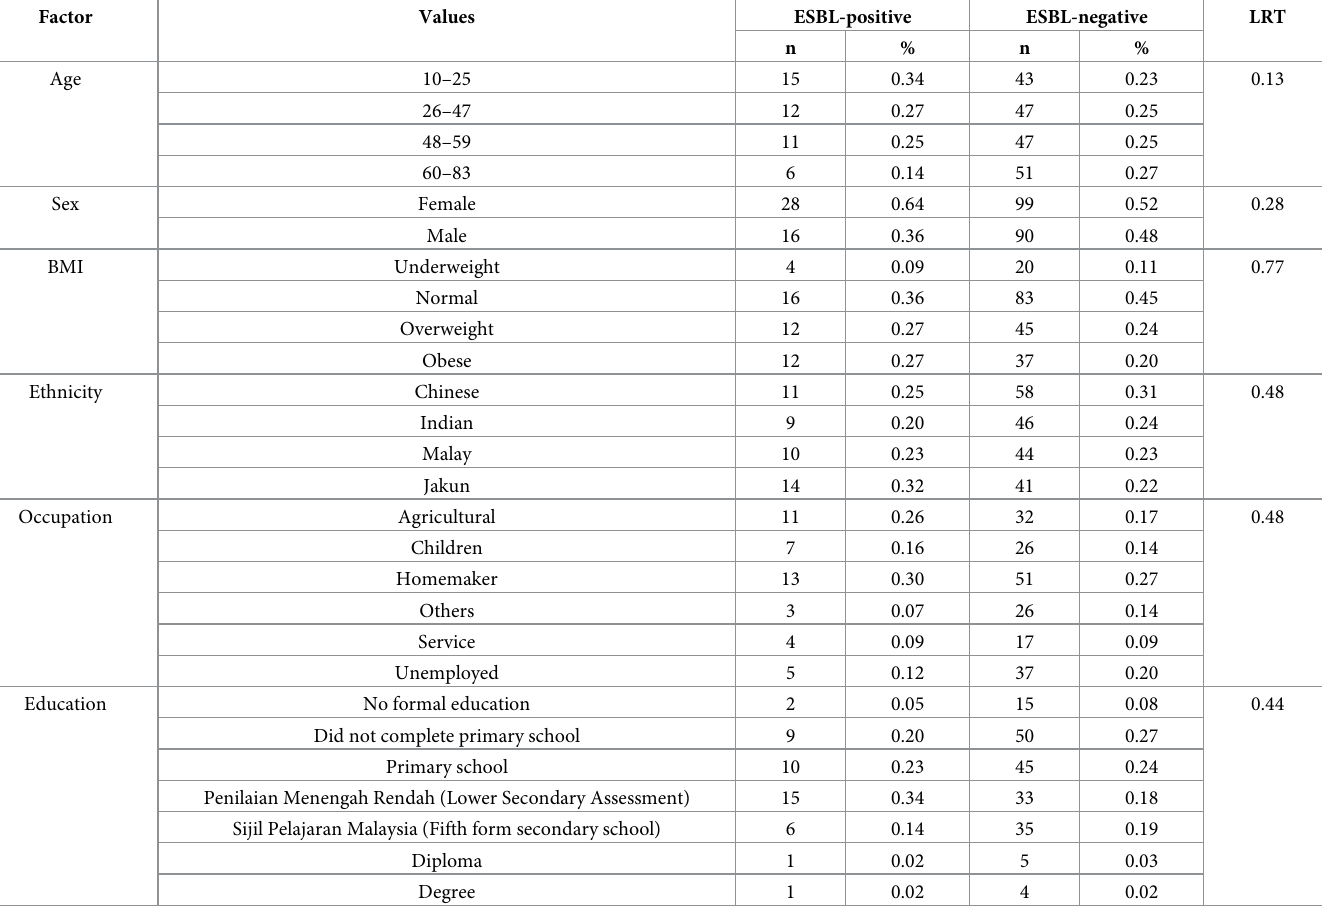
Table 1. Demographic distribution of Segamat community dwellers (n = 233) recruited into this study.